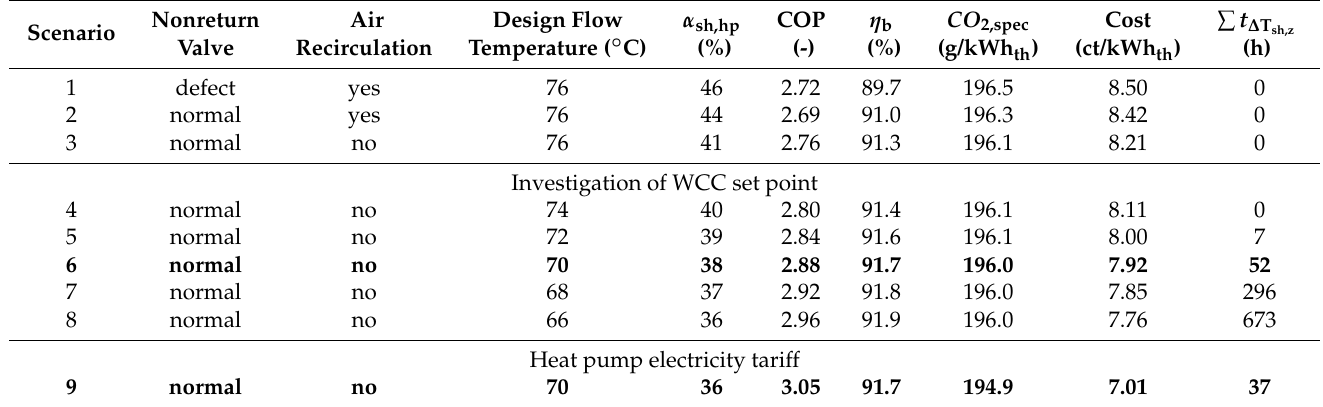
Table 7. Performance indicators of investigated scenarios with different setup